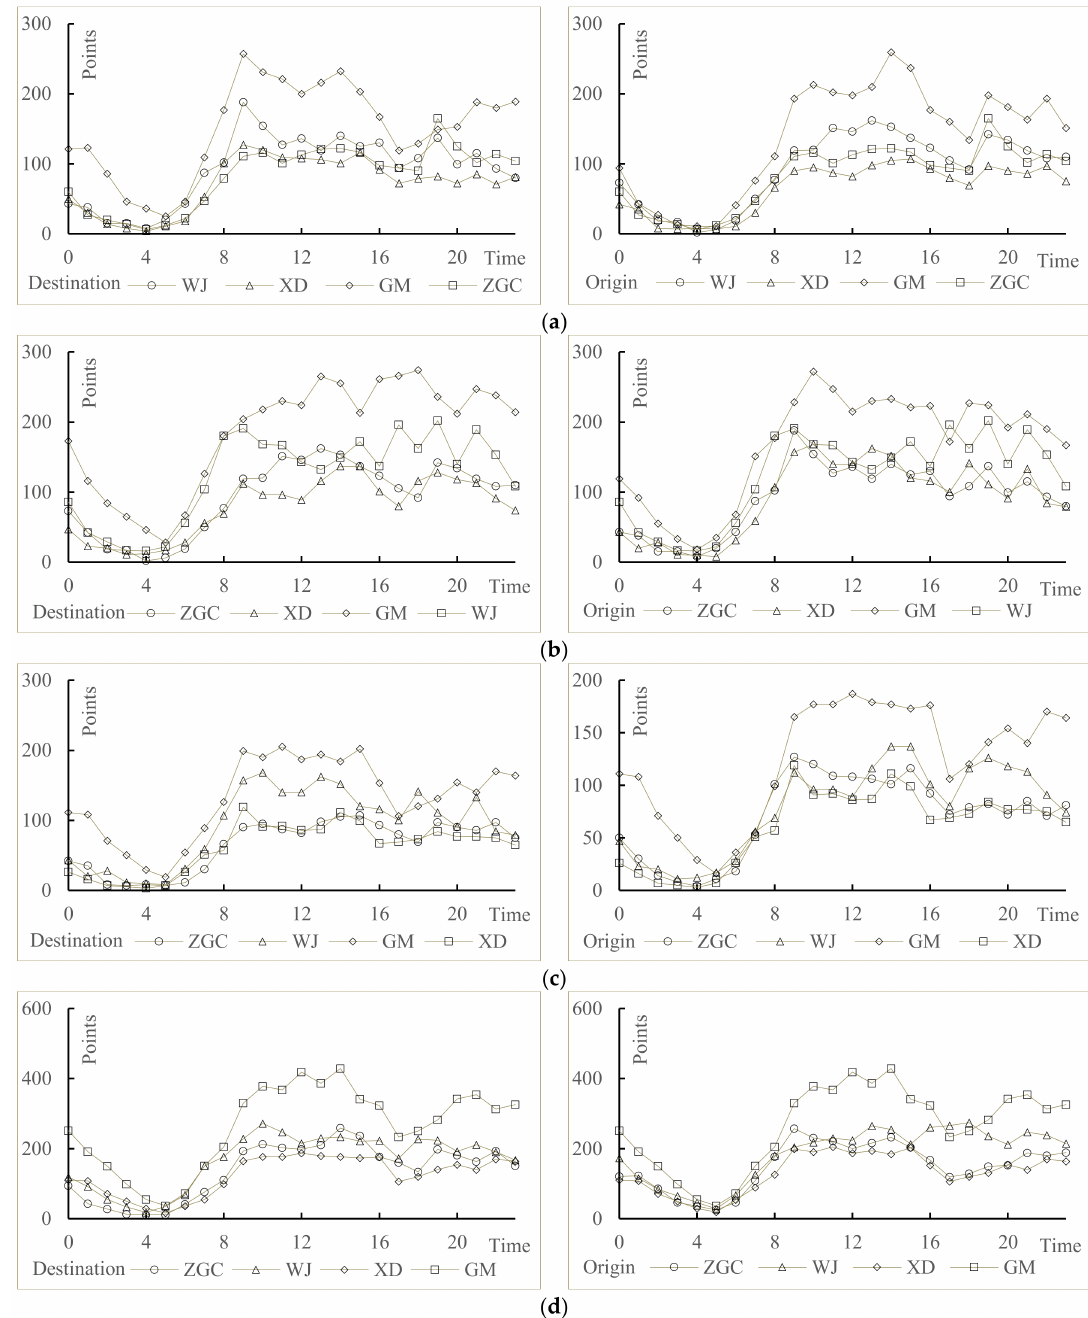
Figure 10. Temporal variations of the four functional regions’ interactions based on O/D points. The left/right map of ( a ) demonstrates that when people take taxis to/from in ZGC, the taxi O/D flows between ZGC and the other three functional regions occur at different time periods daily. Similarly, ( b – d ) represent the temporal variations for WJ, XD and GM,